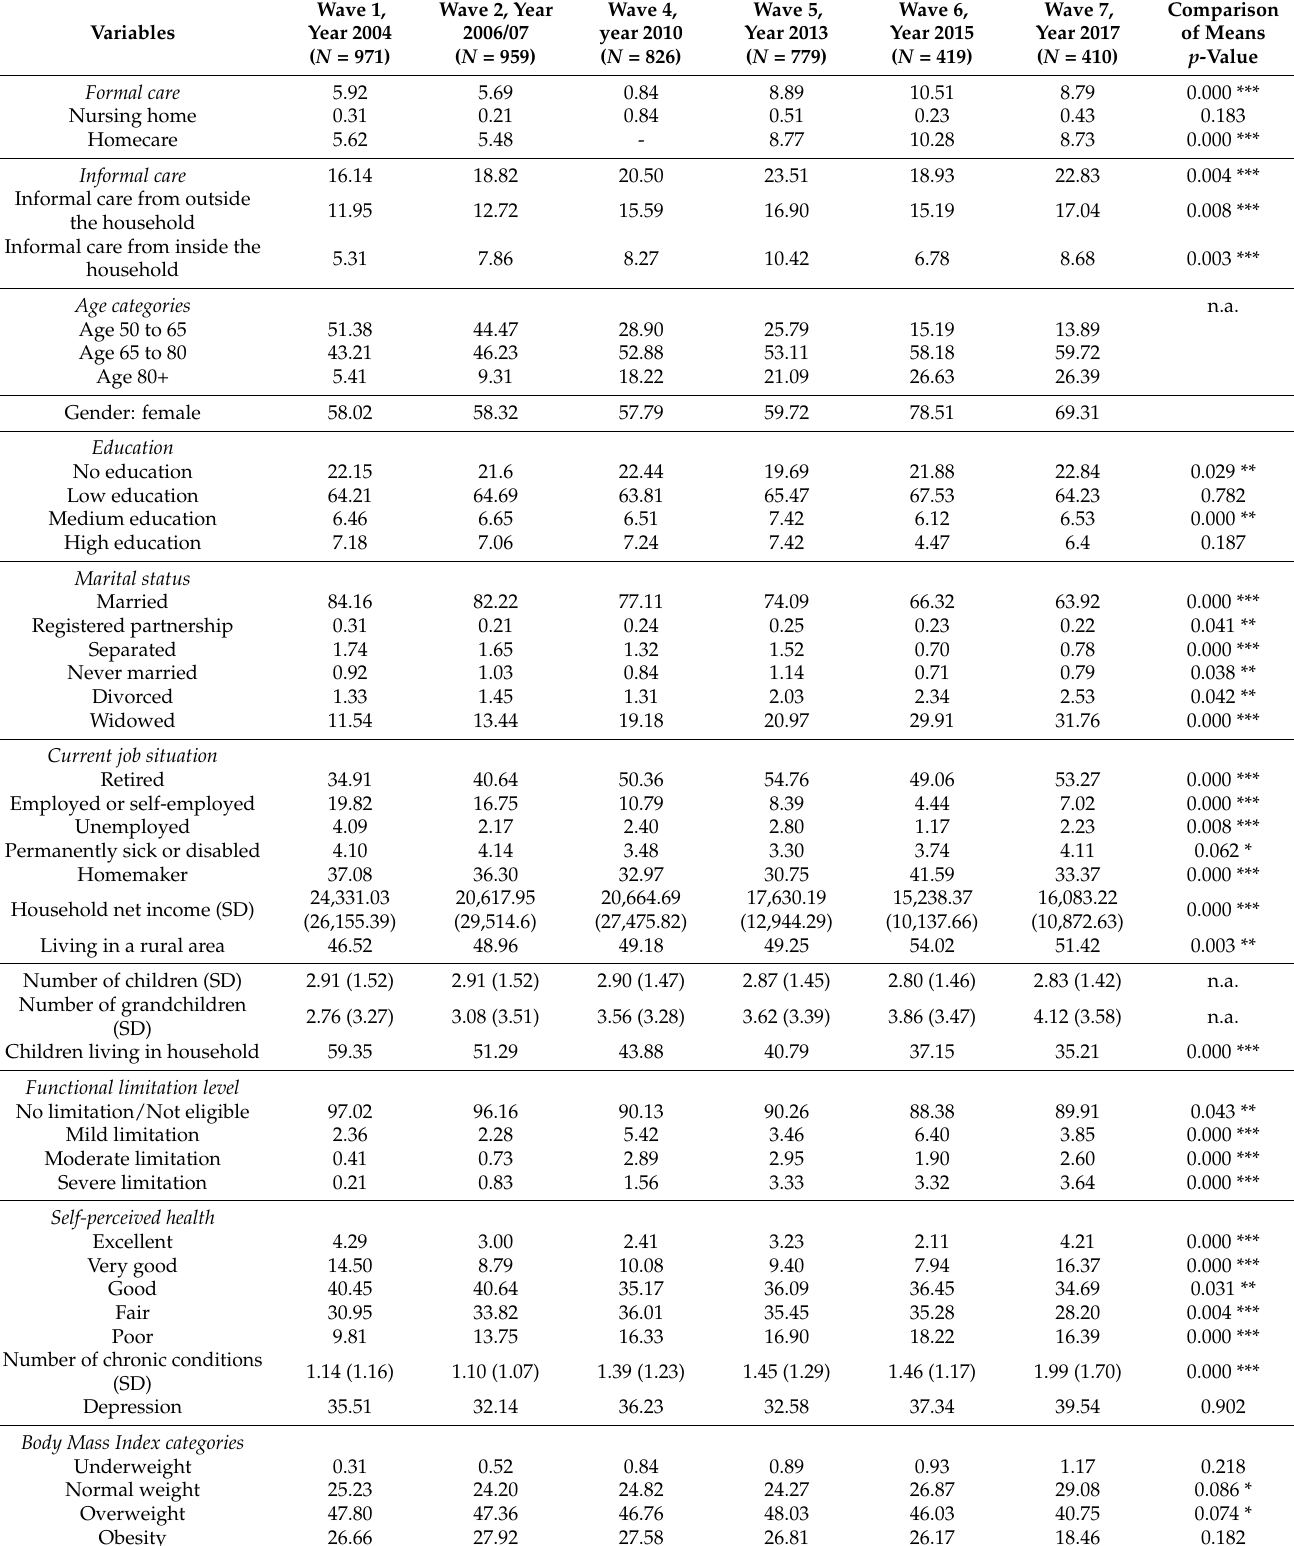
Table 1. Descriptive statistics by year in Spain, n =